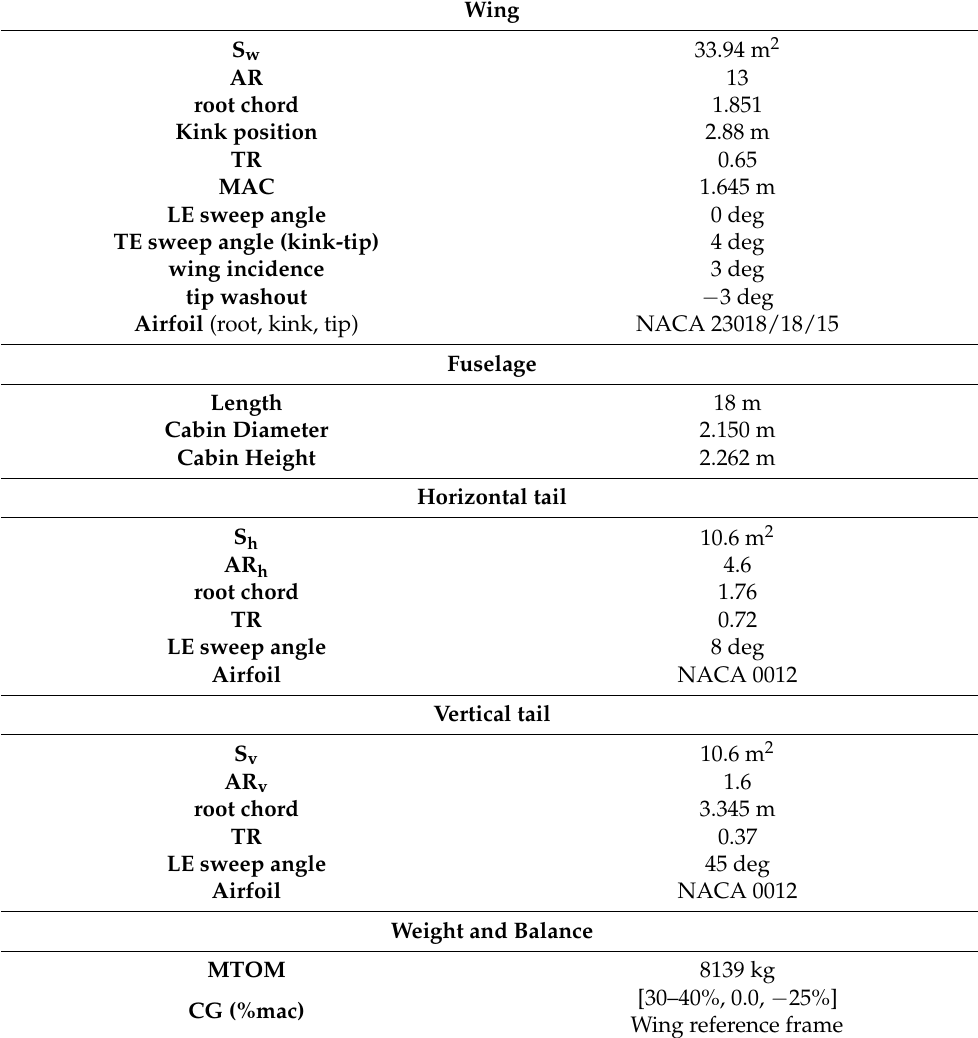
Table 1. Relevant data of innovative aircraft